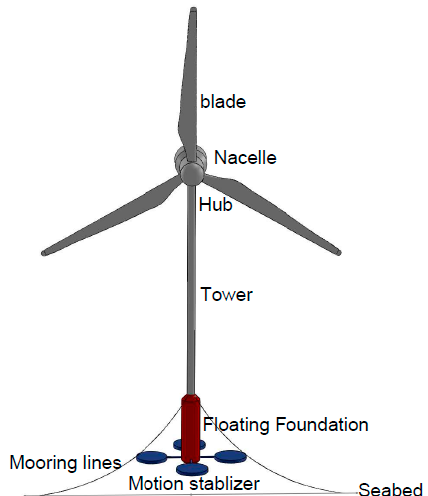
Figure 3. Schematic diagram of the proposed concept motion stabilizer.